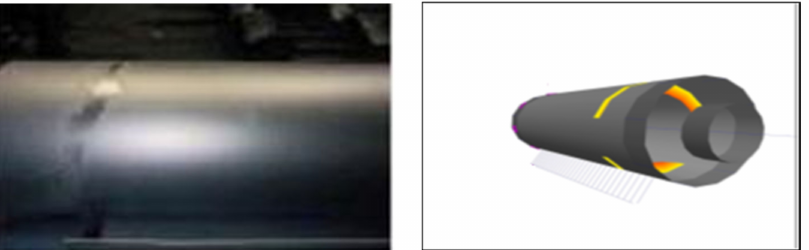
Figure 3. Roller indentation defect mapped in 3D. Source: own, based on